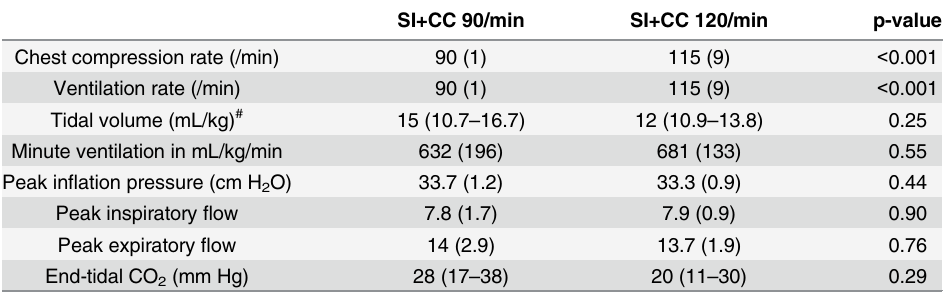
Table 3. Respiratory parameters before